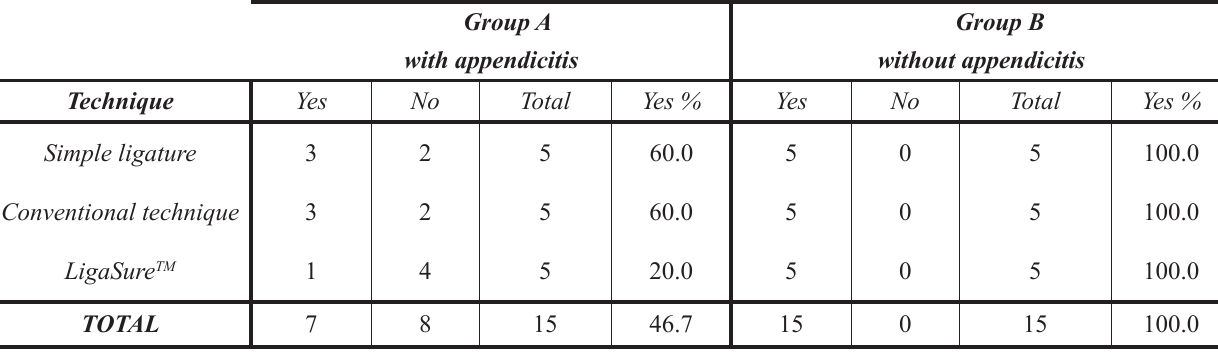
TABLE 6 - Rabbits from groups A and B in the three operative techniques for fibrosis (Figure